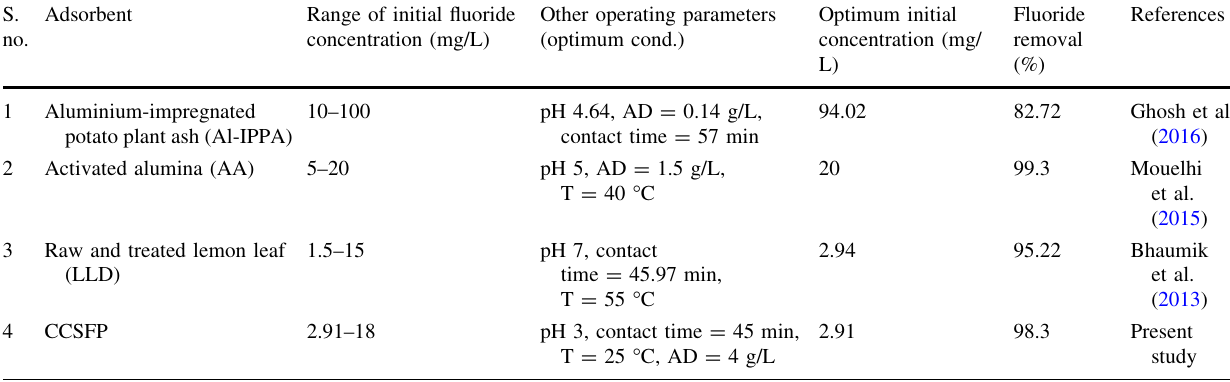
Table 2 Variation of initial concentrations for removal of fluoride using different adsorbents S. no.